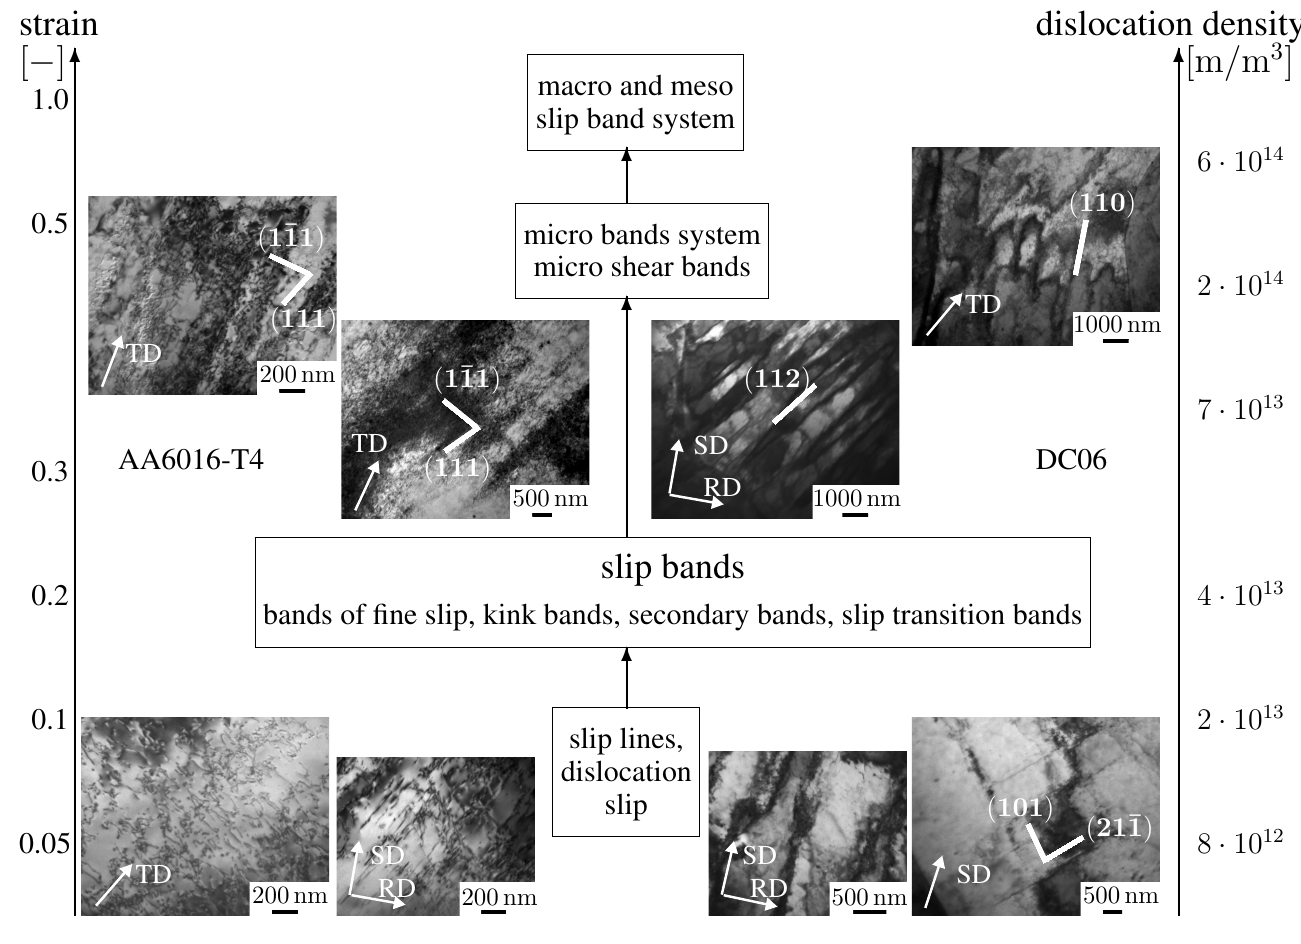
Figure 4. Classification of microstructural elements in aluminum alloy AA6016-T4 and steel DC06 observed at different levels of deformation. These are correlated with the observed dislocation